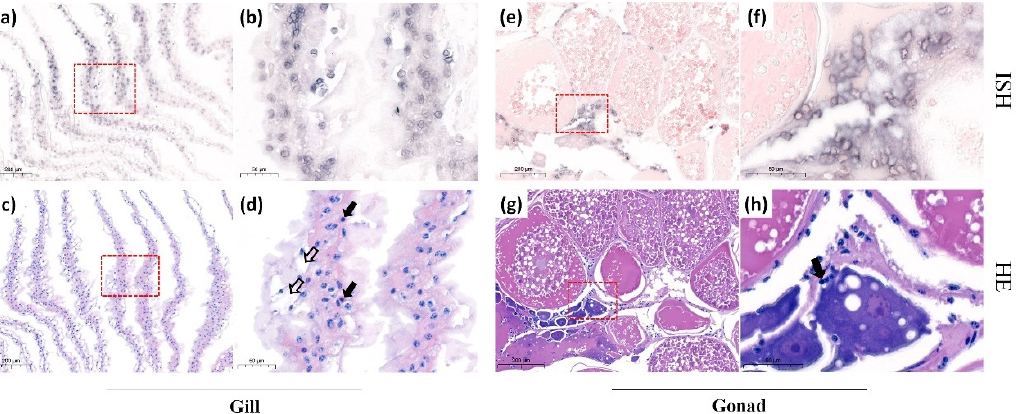
Figure 3. Micrographs of histopathological and in situ hybridization (ISH) assays for the gill and gonad from Macrobrachium rosenbergii naturally infected by covert mortality nodavirus (CMNV). ( a ) ISH micrographs of gill. ( b ) Magnified view of the red-framed areas of ( a ). Note the bluish-purple hybridization signals of CMNV probe. ( c ) H&E staining micrographs of gill histological section. ( d ) Magnified view of the red-framed areas of ( c ). Note the gill tissue edema, extensive vacuolation (hollow arrows) and karyopyknosis (thick black arrows). ( e ) ISH micrographs of gonad histological section. ( f ) Magnified view of the red-framed areas of ( e ). Note the bluish-purple CMNV positive hybridization signals. ( g ) H&E staining micrographs of gonad histological section. ( h ) Magnified view of the red-framed areas of ( g ). Karyopyknosis (thick black arrows) and hemocytes infiltration could be observed in ovary. Scale bars: ( a , c , e , g ) 200 µ m, ( b , d , f , h ) 50 µ